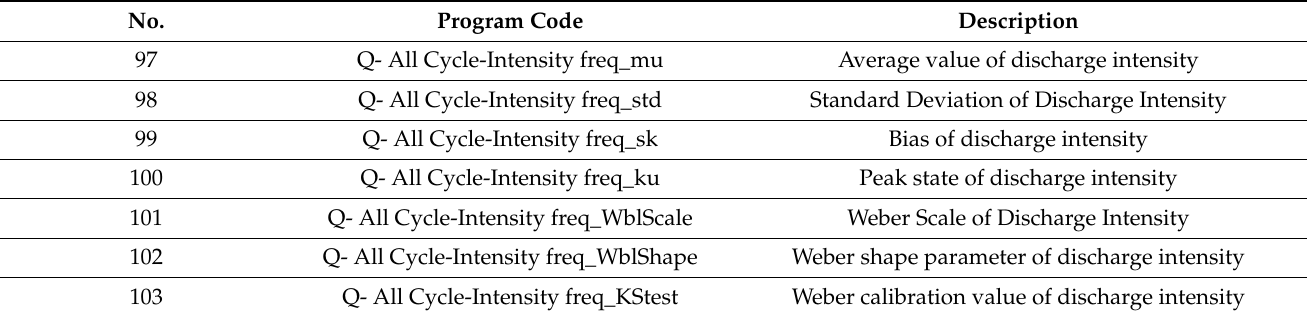
Table 3. Partial discharge characteristic parameters: discharge intensity distribution.